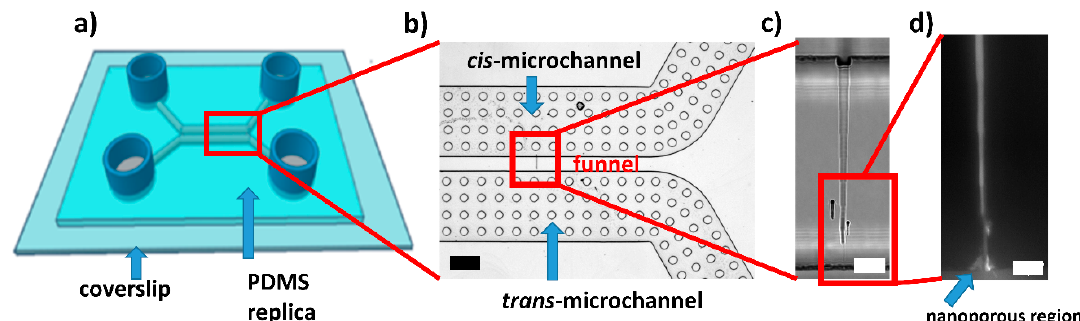
Figure 1. Polydimethylsiloxane (PDMS) miniaturized device: ( a ) schematic representation of the device consisting in a PDMS replica with two U-shaped microchannels (500 µ m wide and 50 µ m deep, separated by a gap 100 µ m thick) sealed to a glass coverslip; ( b ) optical microscope caption of the cis - and trans - microchannels linked by a single funnel (highlighted by the red rectangle) (scale bar 100 µ m); ( c ) bright-field caption of the entire funnel after the junction gap breakdown procedure (scale bar 10 µm); ( d ) epifluorescence microscope image of the nanoporous tip of the funnel, filled with a fluorescent solution, after the junction gap breakdown (scale bar 10 µm).